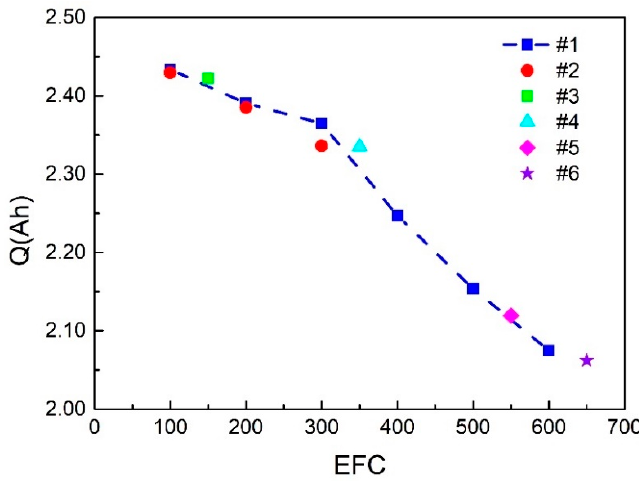
Figure 11. Relationship between capacity and aging cycle.